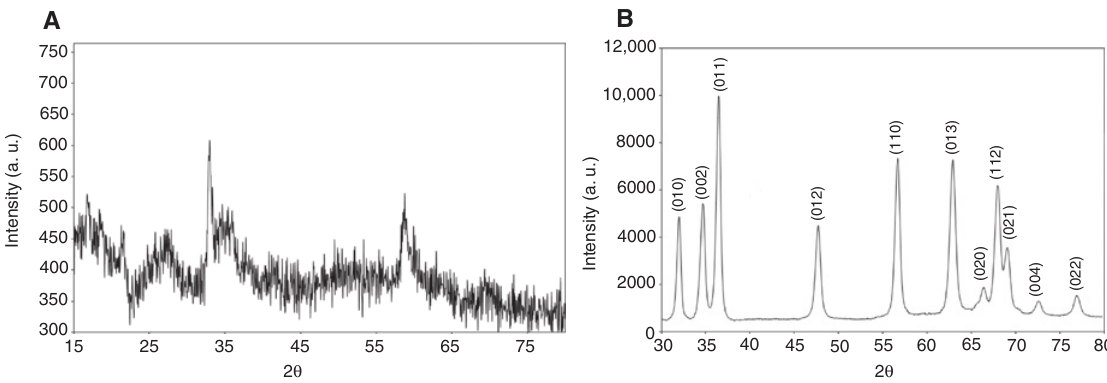
Figure 3: XRD pattern of (A) the precursor and (B) ZnO nanoparticles.